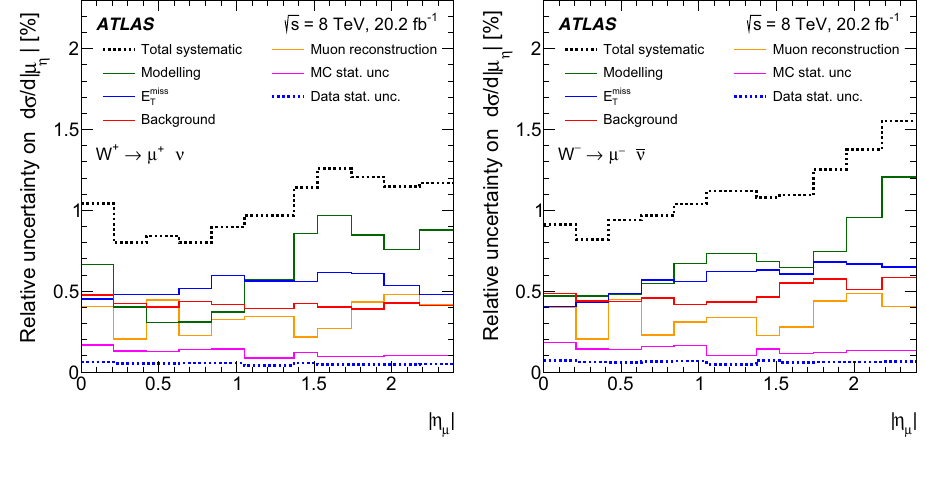
Fig. 2 The relative systematic uncertainty from each source for the W + (left) and W − (right) differential cross-sections as a percentage of the differential cross-section. Also shown are the total systematic and statistical